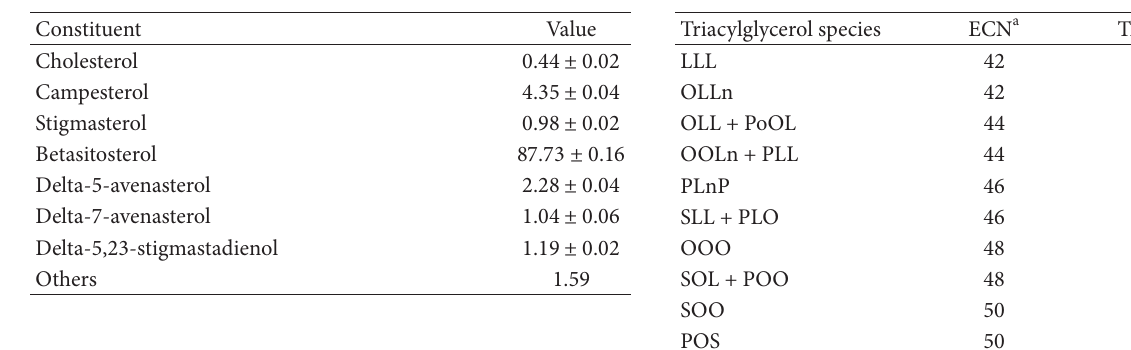
T 2: Sterol composition of Pistacia atlantica seed oil (